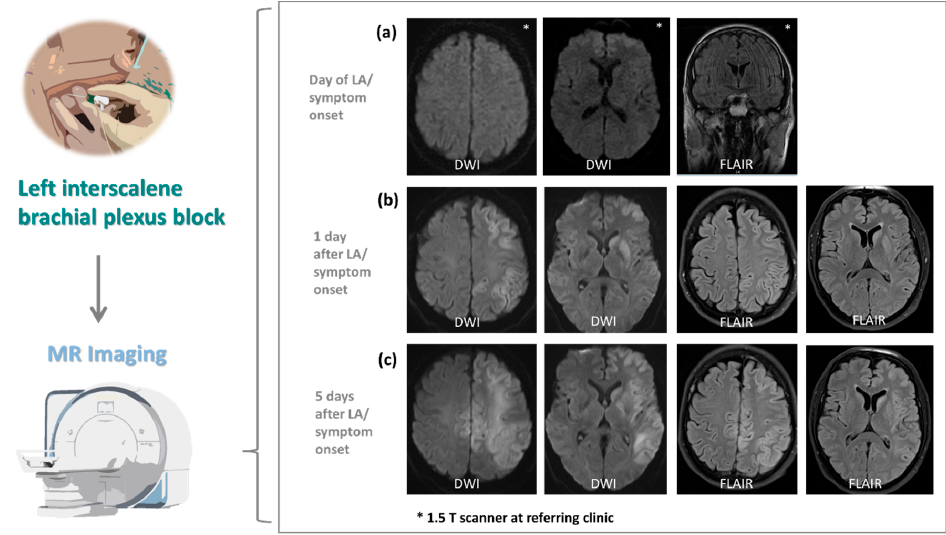
Figure 1. Magnetic resonance imaging (MRI) results of patient 2 admitted to the neurological intensive care unit